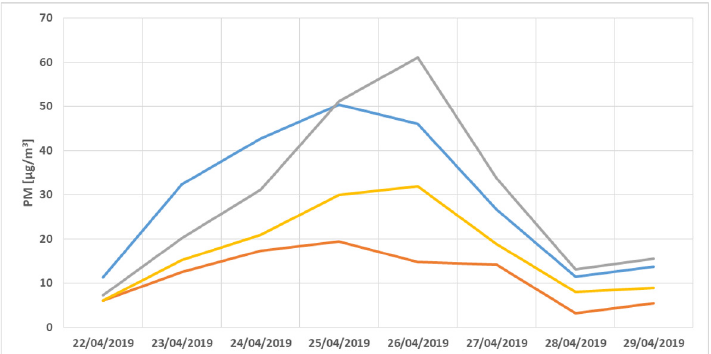
Figure 6. PM—Temporal evolution of daily mean of PM 10 measured with OPC (gray line) and SWAM (blue line) and PM2.5 measured with OPC (yellow line) and SWAM (orange line)